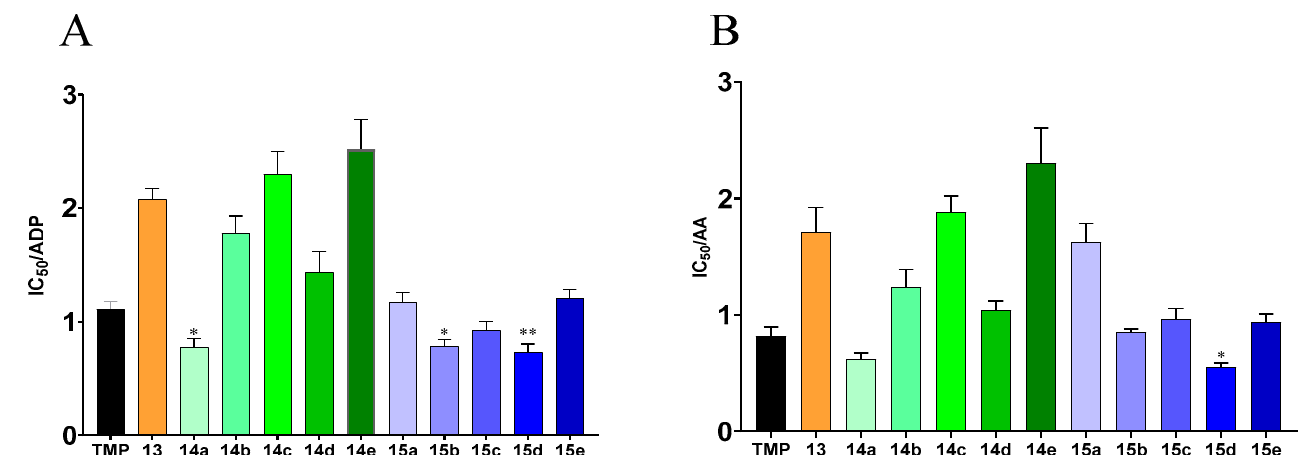
Figure 1. The effect of target compounds on platelet aggregation in vitro. ( A ) The IC 50 values of target compounds against 10 µmol·L − 1 ADP-induced rabbit platelet aggregation in vitro; ( B ) The IC 50 values of target compounds against 1 mmol·L − 1 AA-induced rabbit platelet aggregation in vitro (mean ± SD, n = 5, * p < 0.05, ** p < 0.01 vs. TMP).